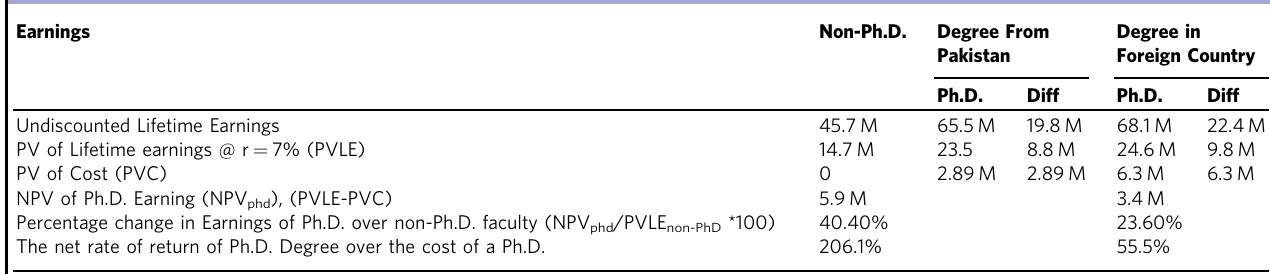
Table 9 Earning ’ s net present value of female Ph.D. over non-Ph.D. faculty.